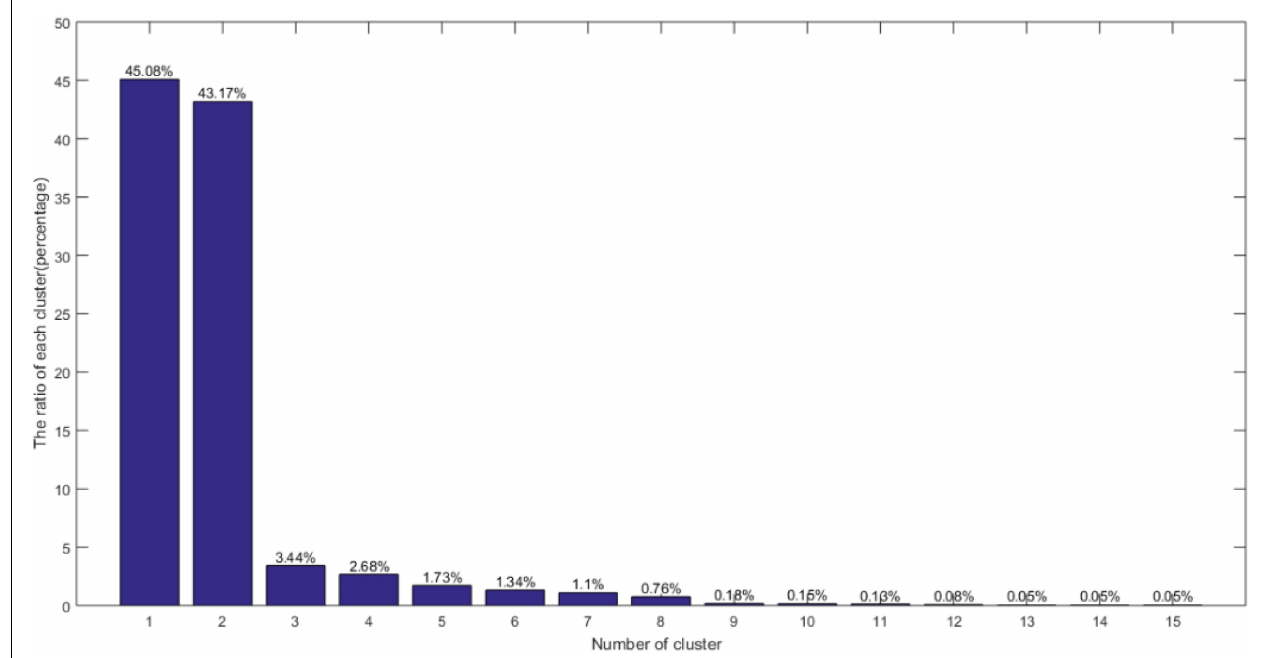
Frontiers in Plant Science |